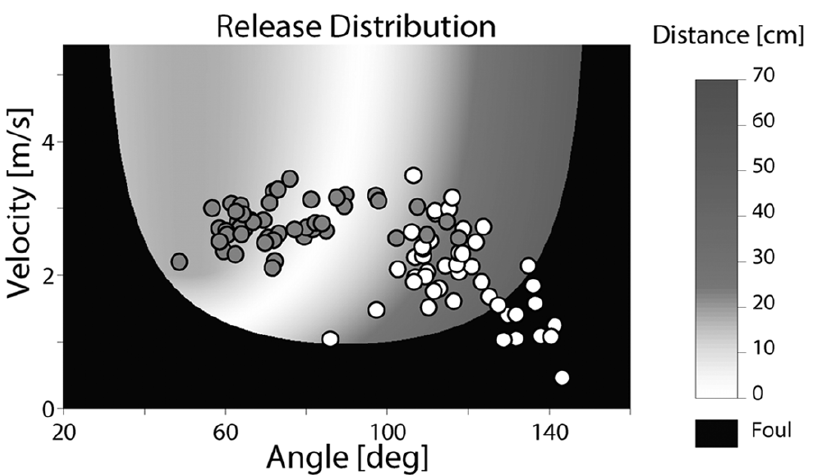
Figure 5. Initial execution areas and their influence on performance. Release and distance to target in execution space for a PD patient (white circles) and a control subject (gray circles) for the first 50 trials of practice.